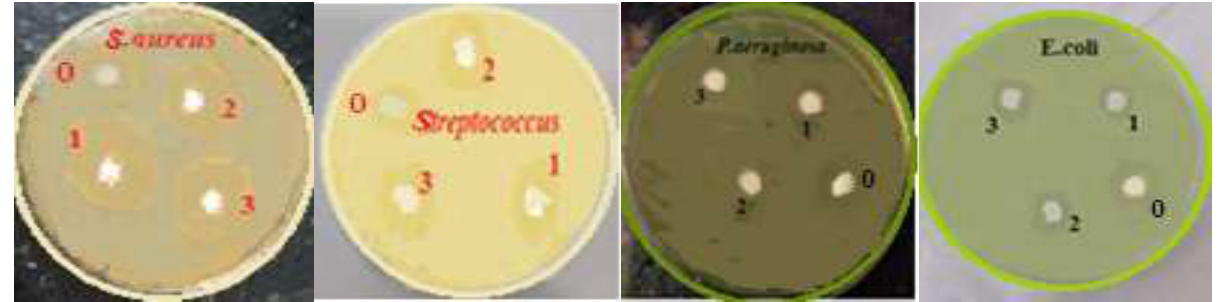
Figure 5: photographs of antimicrobial activity for S.aureus and Streptococcus (gram positive pathogens) , P.aeruginosa and E.coli (gram negative pathogens, which display the variety of inhibition zones diameters as a function of MgO weight and bacteria